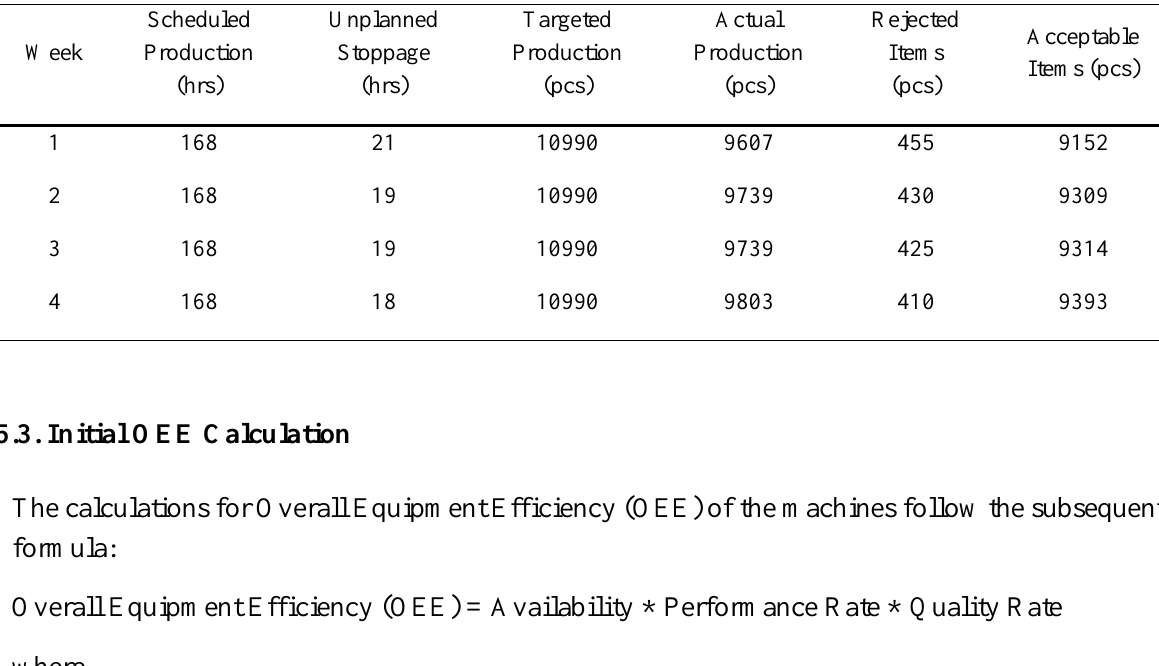
Table 3. Data on vario u s